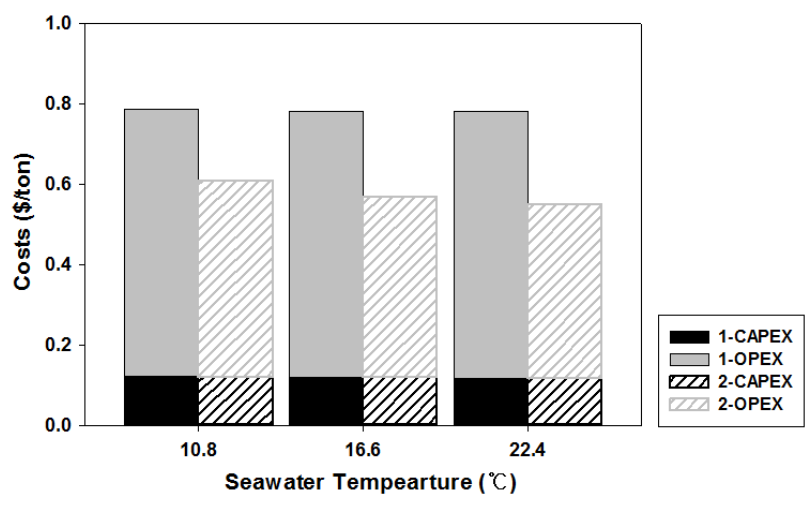
Figure 13. Life-cycle cost at different seawater